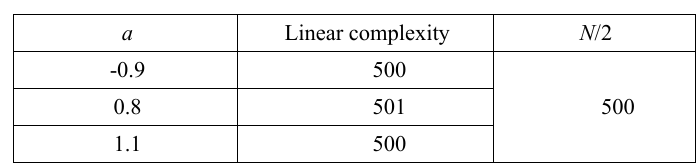
Table 6. Results of linear